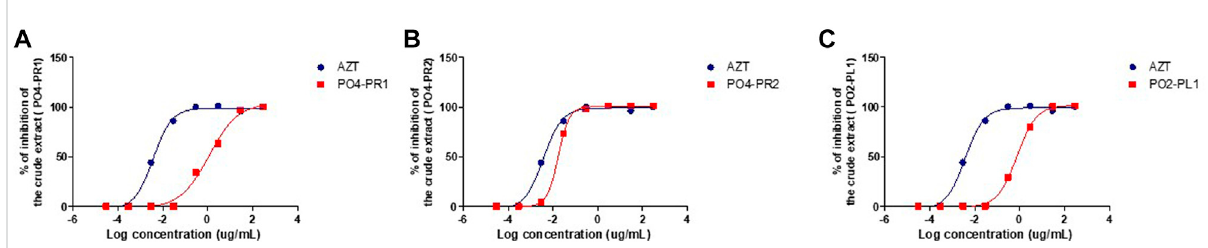
FIGURE 3 Percentage inhibition curves of the endophytic fungi crude extracts tested with Luciferase-based antiviral assay using TZM-bl cell lines. The TZM-blcellswereinfectedwithHIV-1 (NL4.3)andtreatedwiththeserialdilutionofendophyticfungicrudeextractswithAZTaspositive control.The TZM-bl cells (treated and untreated) were incubated for 48 h at 37 ° C and 5% CO 2 . (A) A. alternata PO4PR1 isolated from roots of Hypoxis species (ICso=1.170 μ g/mL) (B) A.alternata PO4-PR2isolatedfromrootsof Hypoxis species(ICso=0.017 μ g/mL),and (C) A.alternata P02-PL1isolated from leaf of S birrea (IC50 = 0.766 μ g/mL).